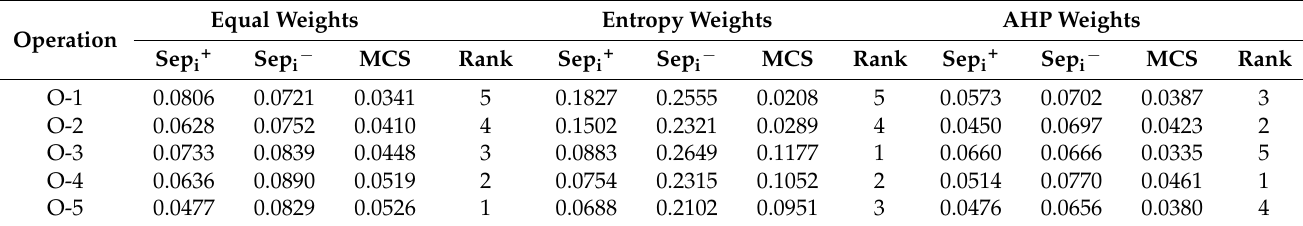
The normalized decision matrix for TOPSIS method calculations was obtained as per Equation (16) and is shown in Table A3. The weighted normalized matrix ( ˆW ˙Z ij ) was computed using Equation (29) and is tabulated in Table A3 for equal, entropy, and AHP weights. The positive ideal (best) answer was calculated using Equation (30), and the negative ideal (worst) response was calculated using Equation (31); the attained values are depicted in Table A6 for equal, entropy, and AHP weights. Equations (32) and (33) were applied to calculate separation measures (Sep m ) for positive and negative answers, respectively. The evaluated responses are depicted in Table 17. The relative closeness or MCS was calculated using Equation (34), and the computed results are tabulated in Table 17. The final ranks attained using the three different weight methods are shown in Table 17. Table 17. Separation measures and multiple composite scores (MCSs).